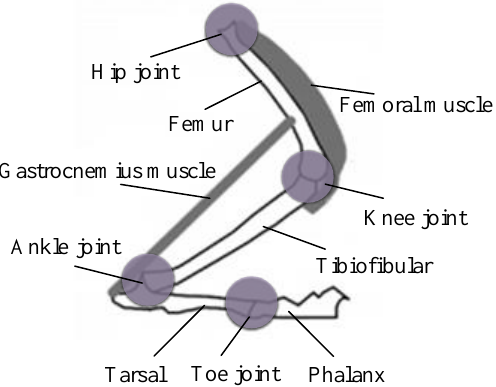
Figure 5. Physiological structure of hind limbs of flying squirrels.